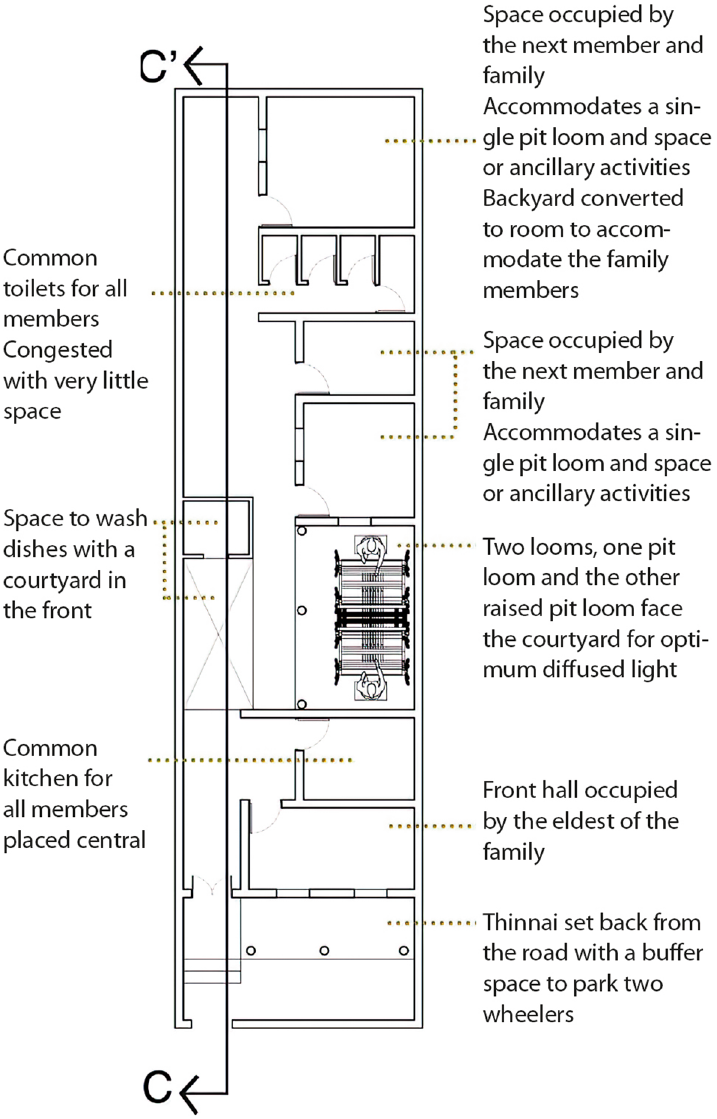
Fig. 19 Floor plan of a joint family dwelling and its spatial characteristics (Source: the author)